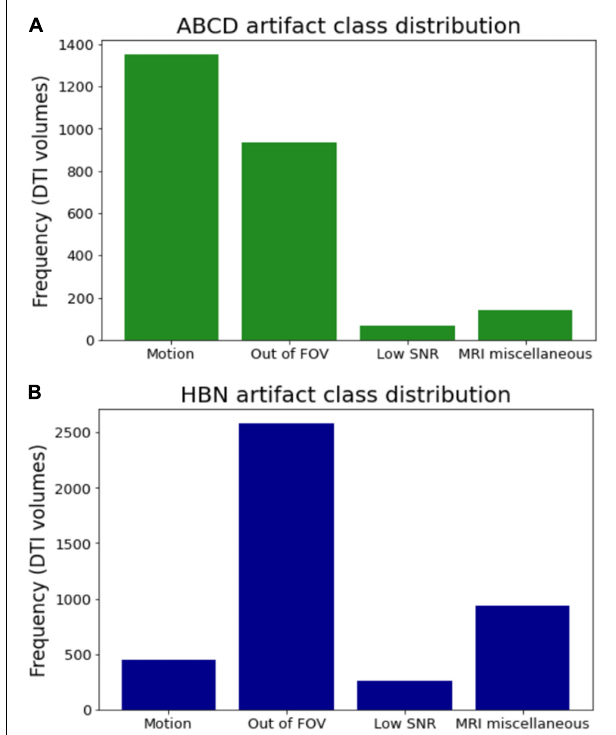
FIGURE 5 | Class distribution for the two datasets. (A) The ABCD dataset has 1,353 volumes contaminated with motion, 933 volumes being out of FOV, 67 volumes with low SNR, and 141 volumes with MRI miscellaneous artifacts. (B) The HBN dataset contains 449 volumes with motion, 2,583 volumes being out of FOV, 258 volumes with low SNR, and 936 volumes with MRI miscellaneous artifacts.